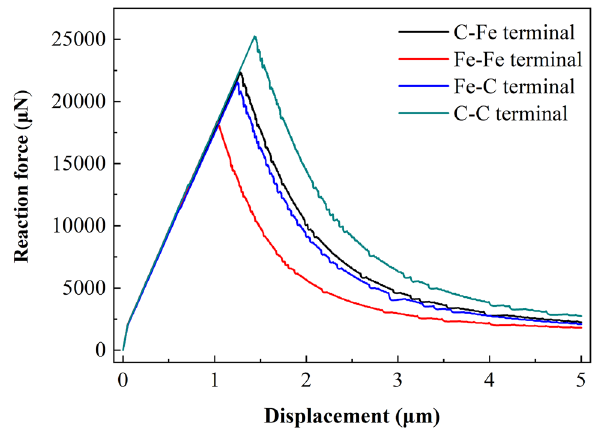
Figure 21. Displacement vs reaction force at loading point (250 μm × 240 μm).